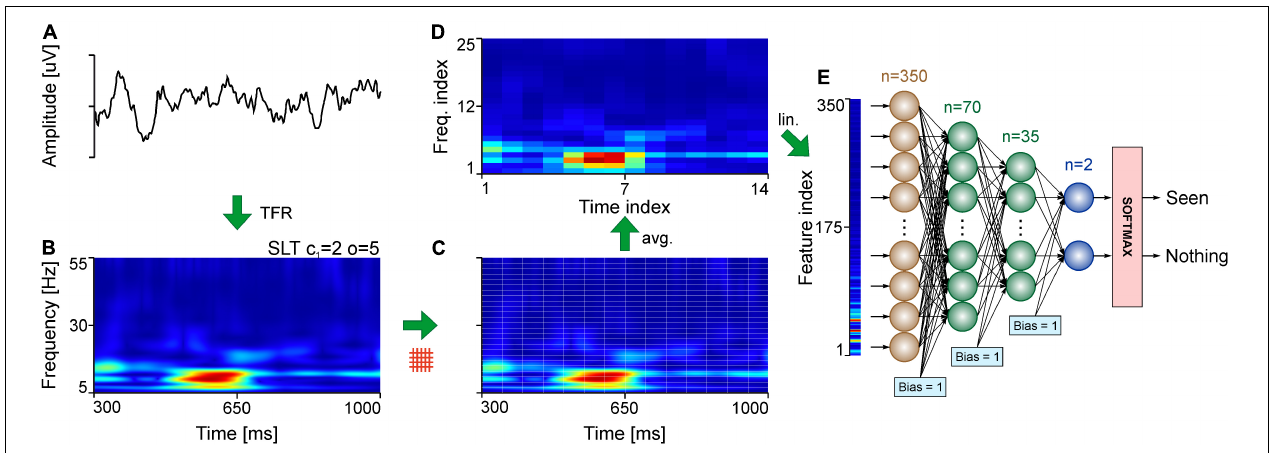
FIGURE 1 | Analysis pipeline for evaluating TFRs. (A) Example of single trial EEG signal. (B) TFR using the SLT of the EEG signal in panel (A) . (C) Slicing of the TFR into time-frequency tiles. (D) Standardization of the TFR tiles using bicubic interpolation. (E) Linearization of the tiled, interpolated TFR in panel (D) , fed to the MLP. The example indicates the application of the pipeline for a single trial of the EEG